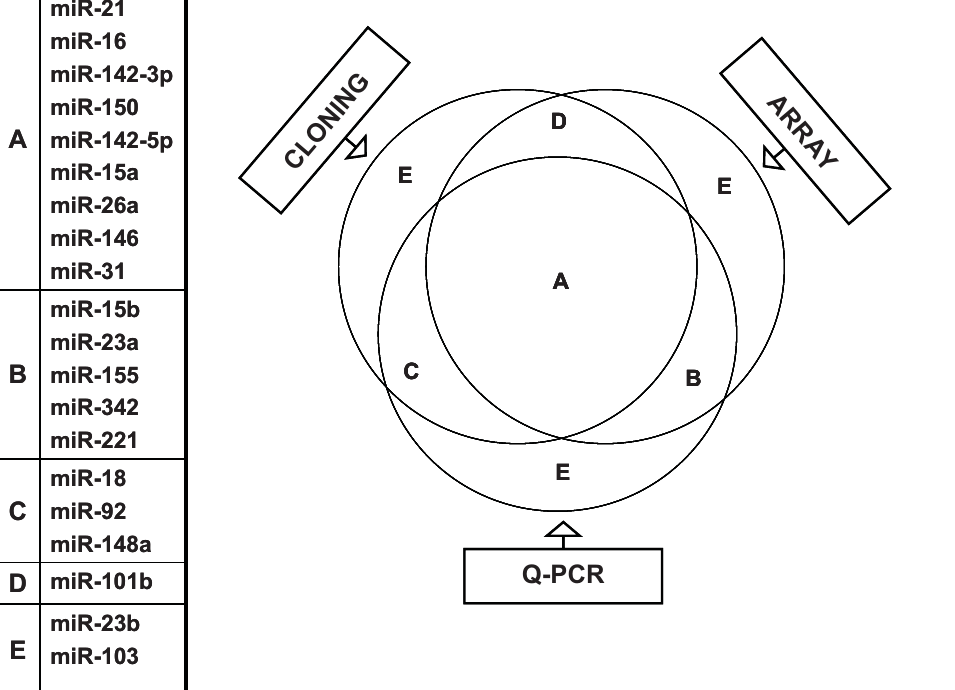
Figure 4. Correlation amongst three methods of miRNA expression profiling. Twenty different miRNAs (indicated on the left) that were picked up by direct cloning and/or microarray hybridization were also tested by real time PCR. A shows miRNAs whose relative expression between naı¨ve, effector and memory T cells correlated in all 3 methods. B shows miRNAs with expression profile correlated only in the microarray and real time RT- PCR. C shows the expression profile that correlated only in cloning and RT-PCR. D shows the expression profile that correlated only in cloning and microarray and E represents the miRNAs that did not correlate in any two methods. The correlation was determined arbitrarily according to their movement in the same direction in the different assays.